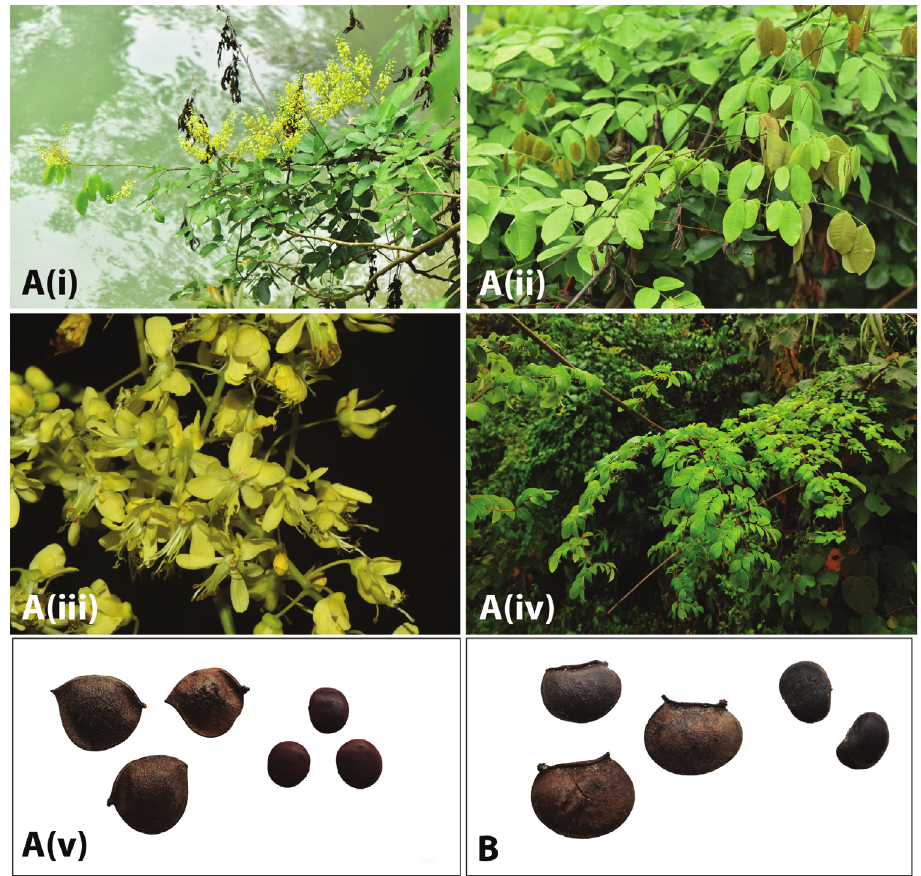
Figure 2. Photos of Ticanto A T. crista (i) habit (ii) leaves (iii) flowers ( E.D. Liu 8629 , Yunnan, China (KUN)) (iv) leaves ( K.W. Jiang KwT033 (NPH)) (v) fruit and seeds ( Z.Q. Song s.n. (fruit and seeds in NPH)) B T. magnifoliolata fruit and seeds ( Q. Meng s.n. , Guizhou, China (fruit and seeds in NPH))